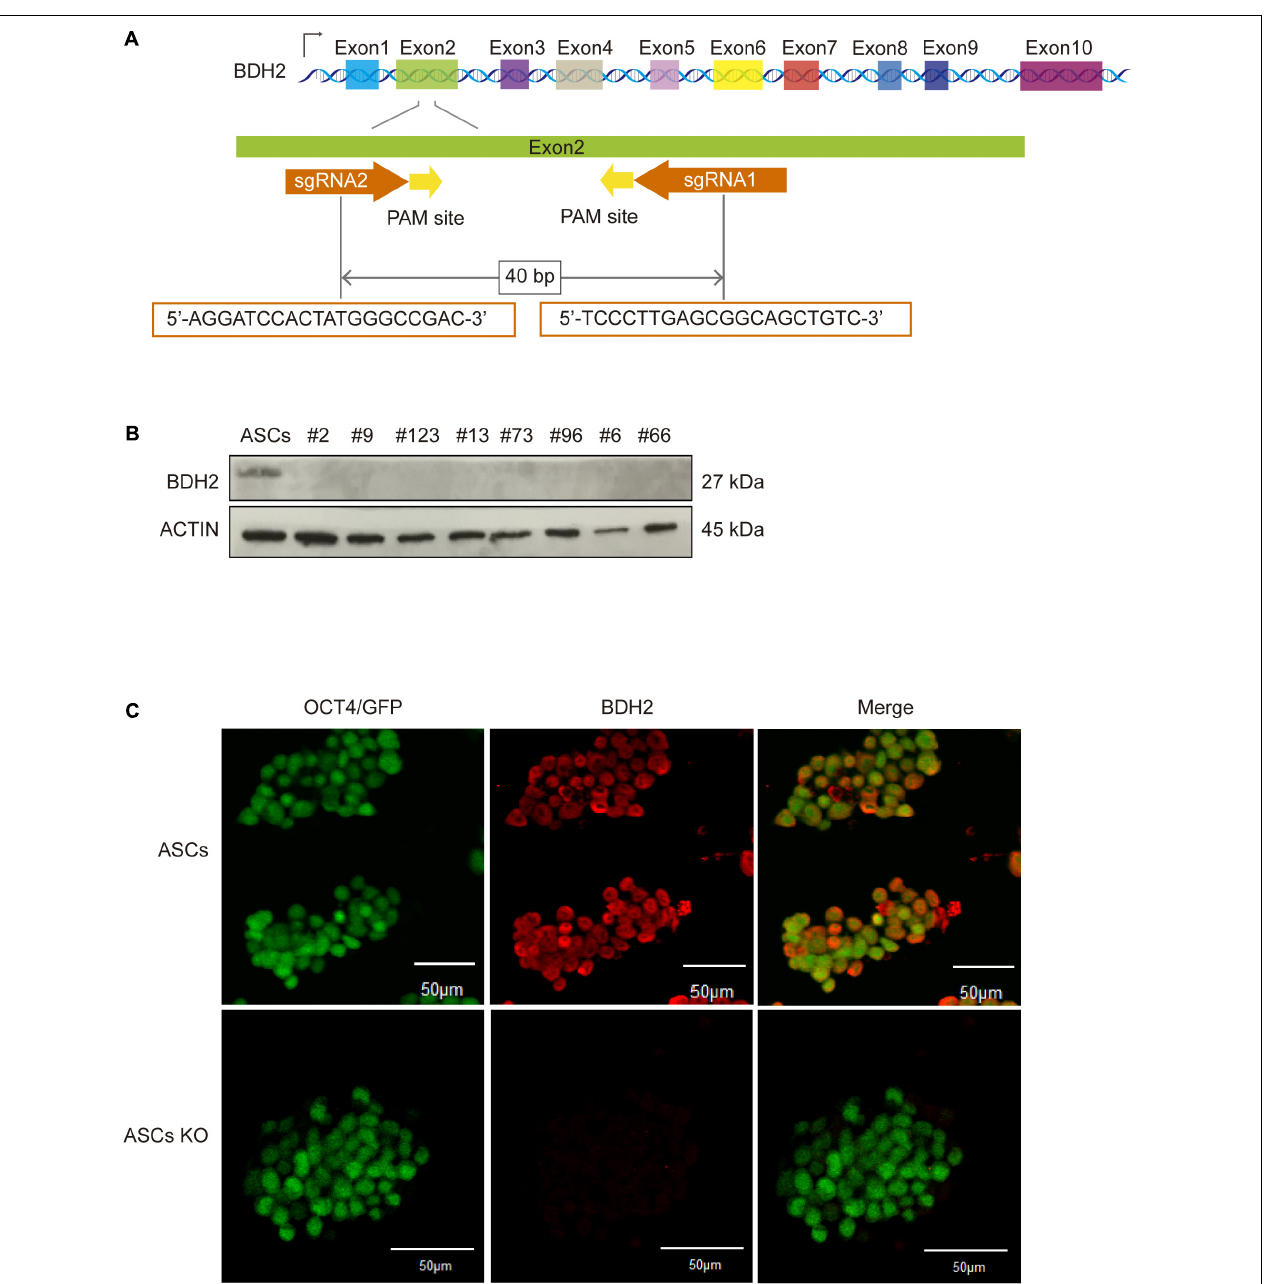
FIGURE 1 | Generation and identification of bi-allelic Bdh2 -knockout mouse advanced pluripotent stem cells (ASCs). (A) Schematic of the exon of Bdh2 gene and location of gRNAs. (B) Western blotting was used to detect the expression of BDH2 in the above eight knockout cells. (C) Immunostaining for BDH2 in ASCs and bi-allelic 56-nt clone. nt, nucleotide; PCR, polymerase chain reaction. Scale bars, 50 µ